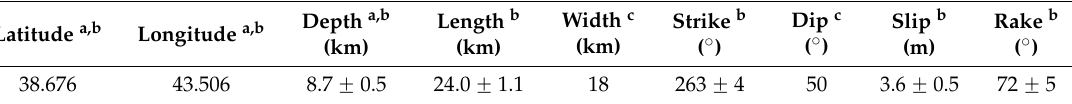
Table 2. Fault parameters retrieved by non-linear